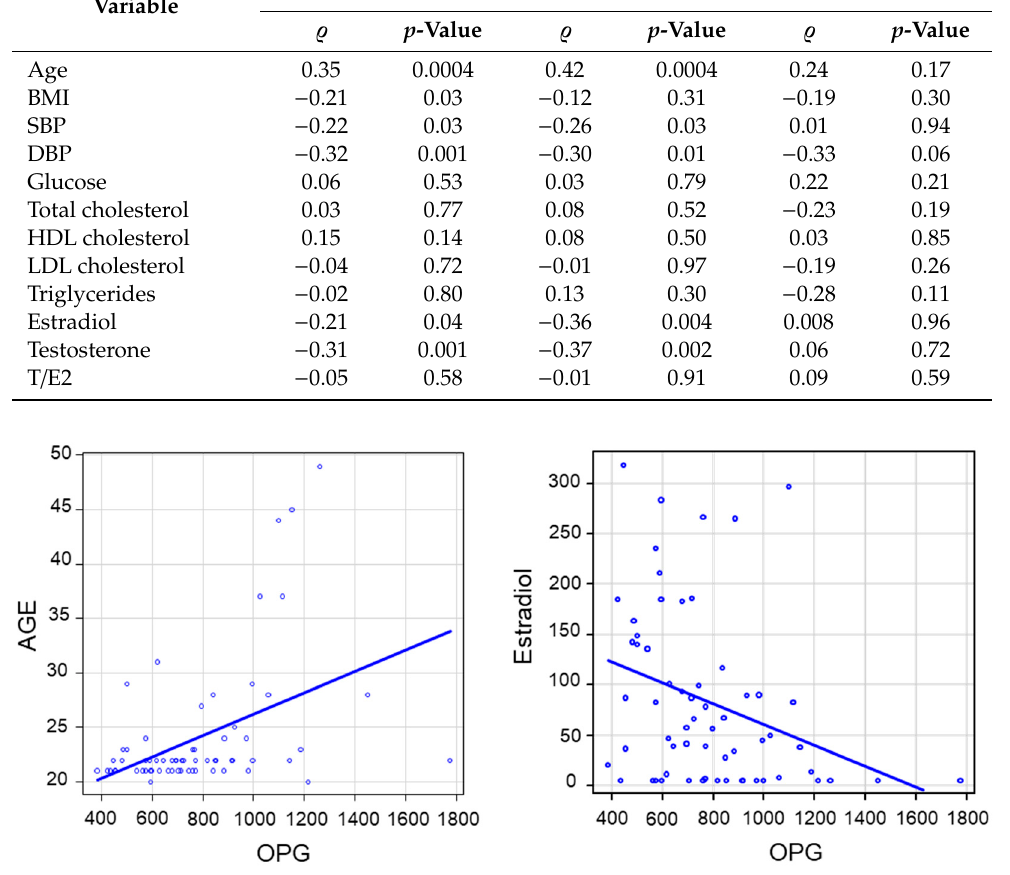
Figure 2. Correlations between age and OPG, and estradiol and OPG, in the subgroup of women.